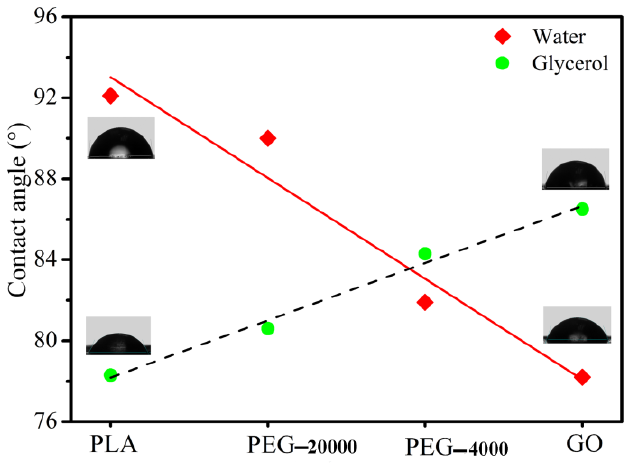
Figure 1. Photographs of contact angles (at 25 ◦ C) and measured contact angles of sole sample. Table 2. The contact angles (25 ◦ C) and surface energies of sample components. Contact Angle ( ◦ ) Sample — Glycerol